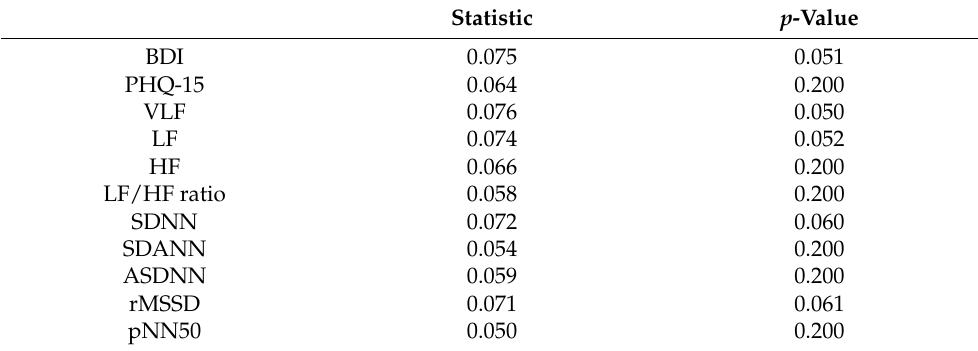
Table 2. Kolmogorov–Smirnov test results.